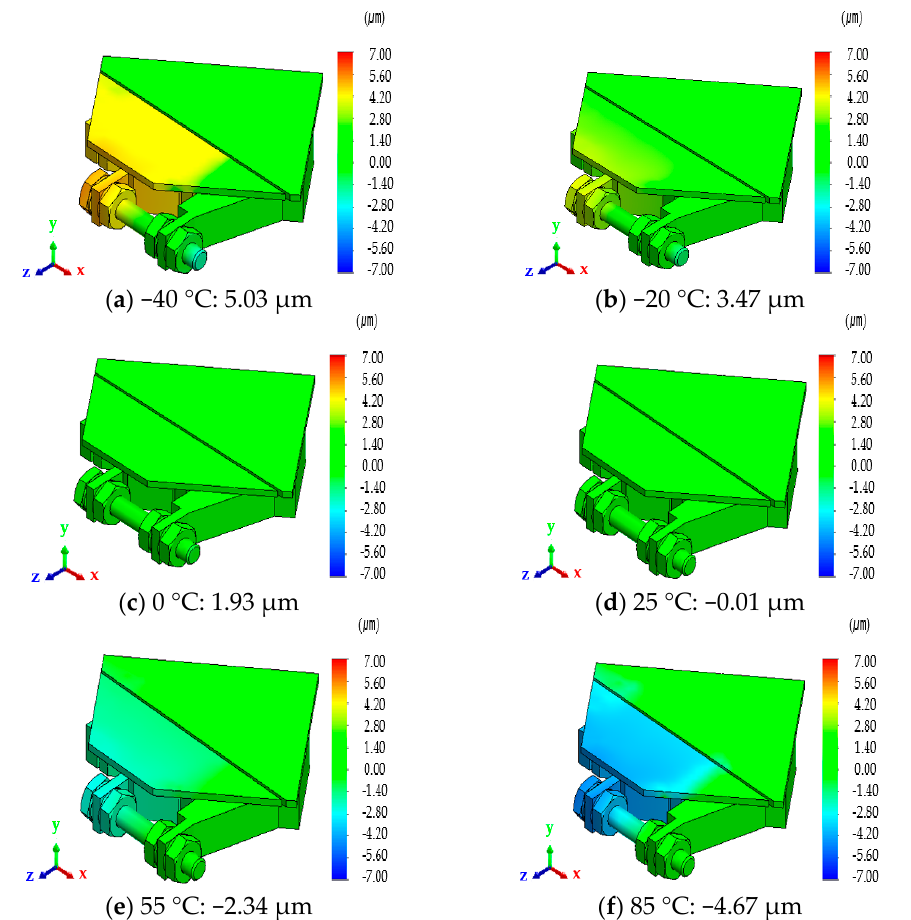
Figure 3. Strain distribution by temperature of the temperature-compensated substrate.